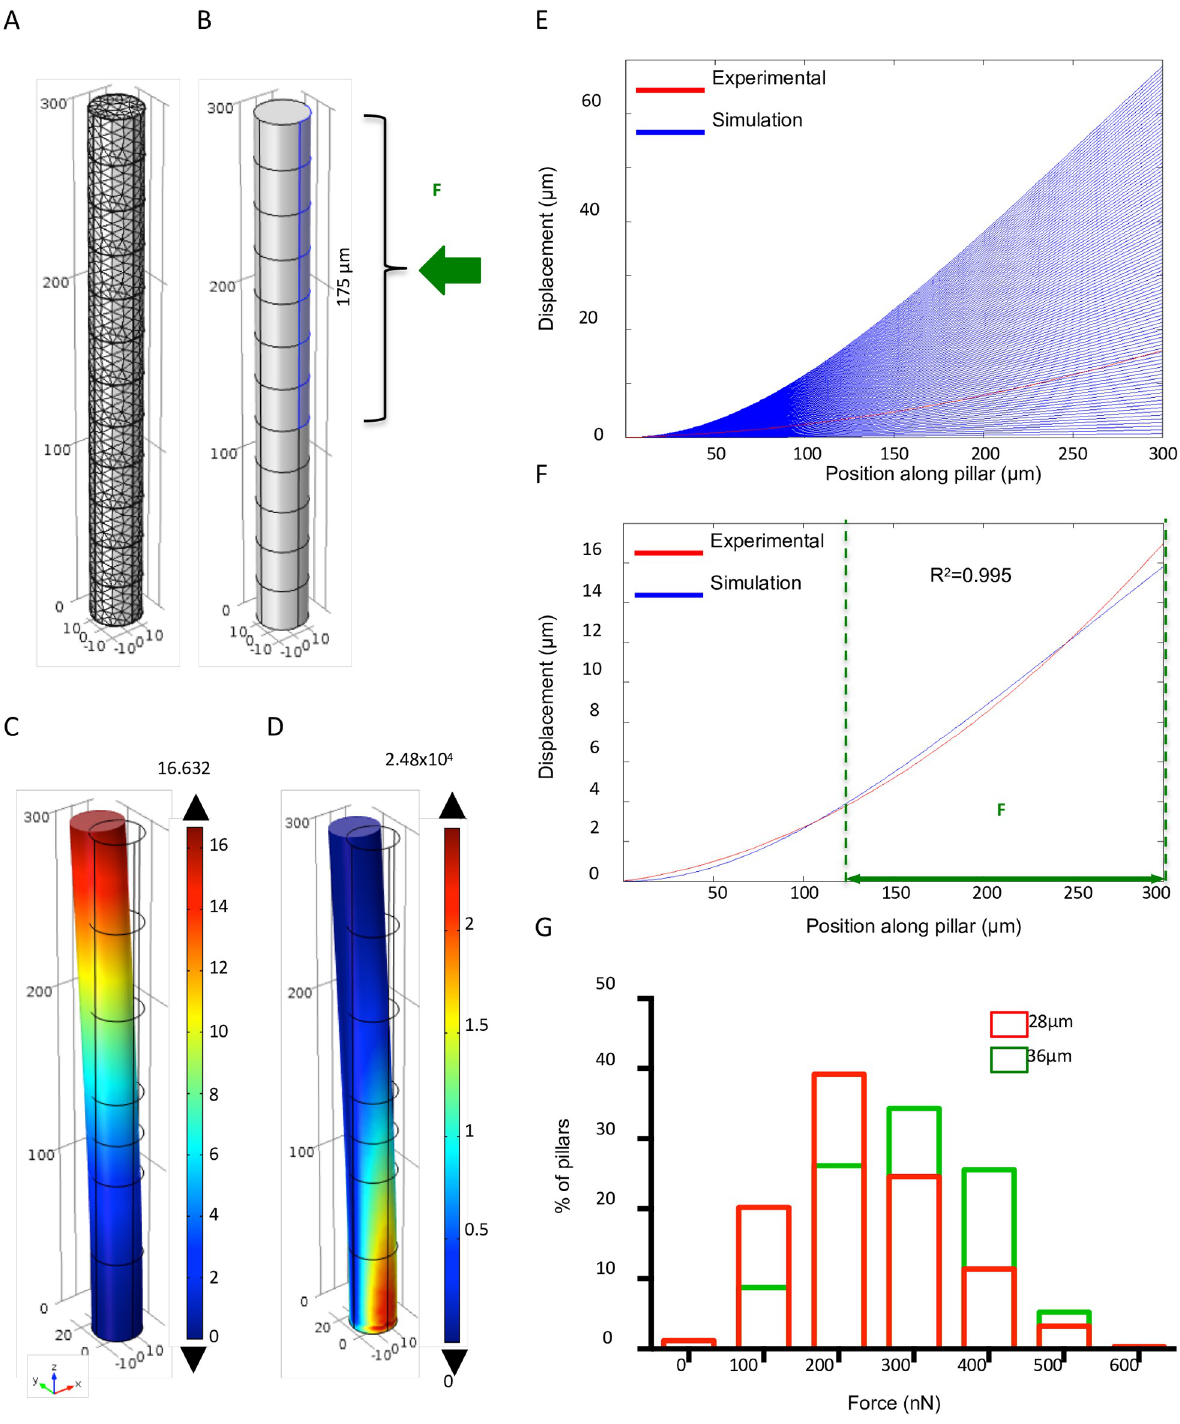
Fig 4. Determination of the forces exerted by growing spheroids based on pillar deflection using the finite-element method analysis. (A) Fine tetrahedral meshing of the whole micropillar. (B) 3D model of the cylindrical micropillar with the introduced geometrical and material parameters. The uniform unidirectional boundary of the force (F) load on the upper 175 μ m of the pillar length is highlighted in blue. (C) Pillar deflection: the highest deformation is at the pillar top (colour code unit: μ m). (D) Von Mises stress for the deformed pillar showing the highest stress at the fixed bottom (colour code unit: N/m 2 ). (E) Abacus of pillar deflection curves according to the range of applied forces (blue). The deformation curve obtained using the experimental data for one pillar is shown in red. (F) Comparison of the experimental (red) and best-fitted simulated curve (blue)